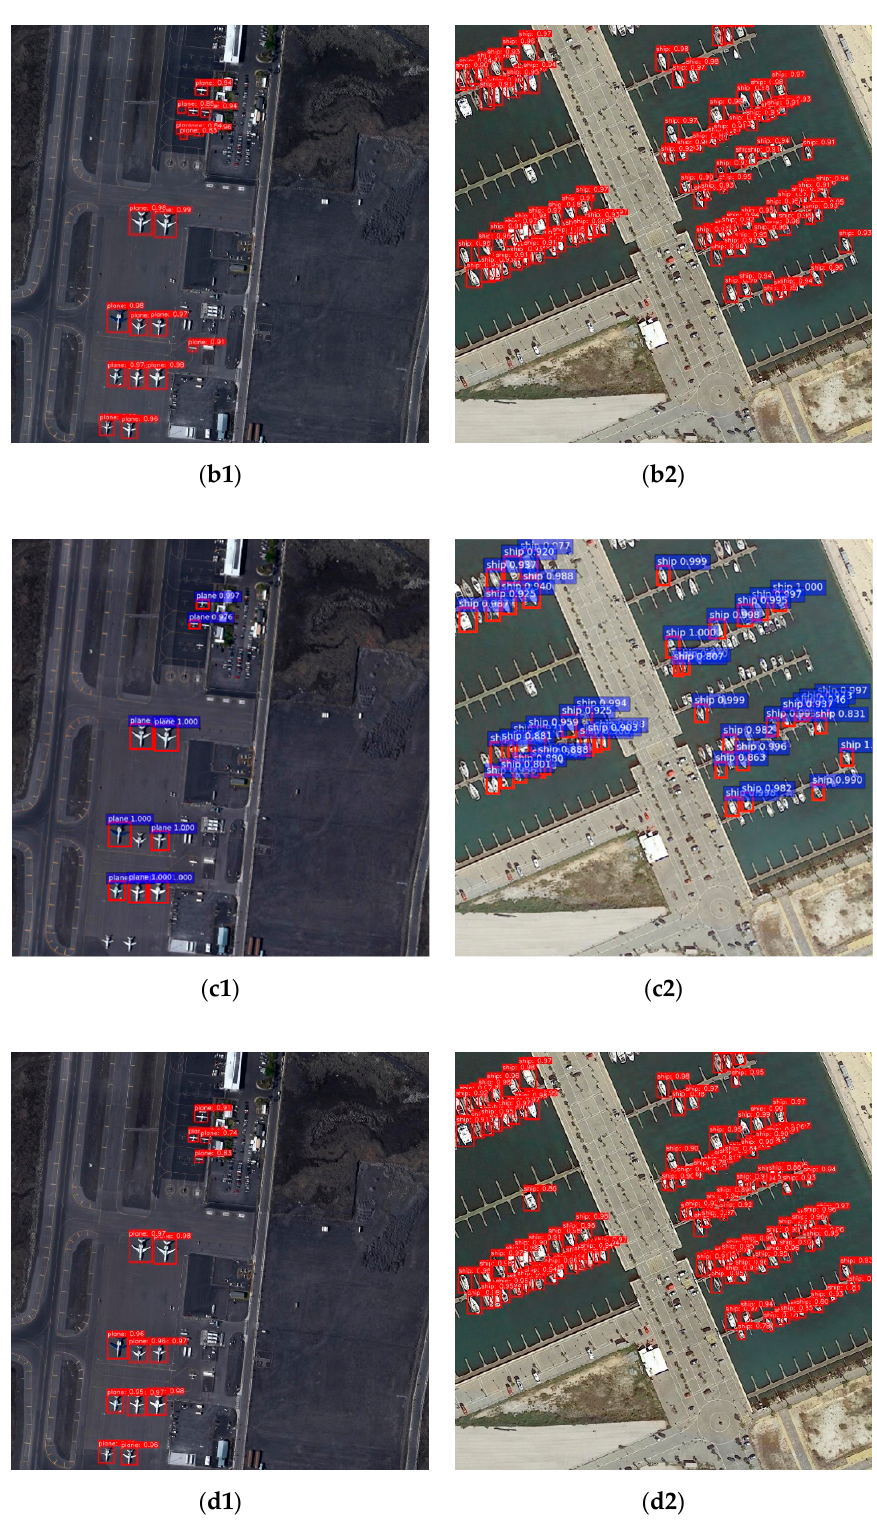
Figure 10. The detection results of different algorithms on two datasets. ( a1 )–( d1 ): MyPlane dataset; ( a2 )–( d2 ): MyShip dataset. ( a1 ) and ( a2 ) are the detection results of the Faster R-CNN+Resnet101 model; ( b1 ) and ( b2 ) are the detection results of the Faster R-CNN+VGG16 model; ( c1 ) and ( c2 ) are the detection results of the YOLOv3 model; ( d1 ) and ( d2 ) are the detection results of the proposed model in this paper.